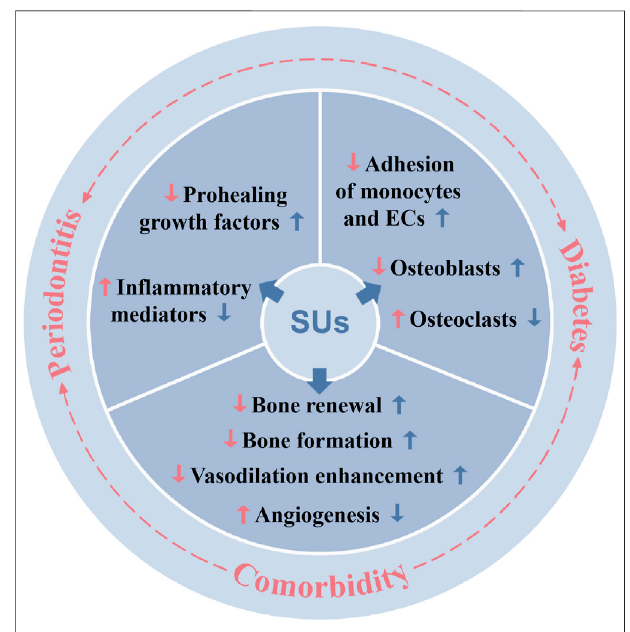
FIGURE 6 | Periodontitis, diabetes, and periodontitis-diabetes comorbidity affects various local and systemic functions, and sulfonylureas had shown potential to alleviate those effects. SUs: sulfonylureas; ECs: endothelial